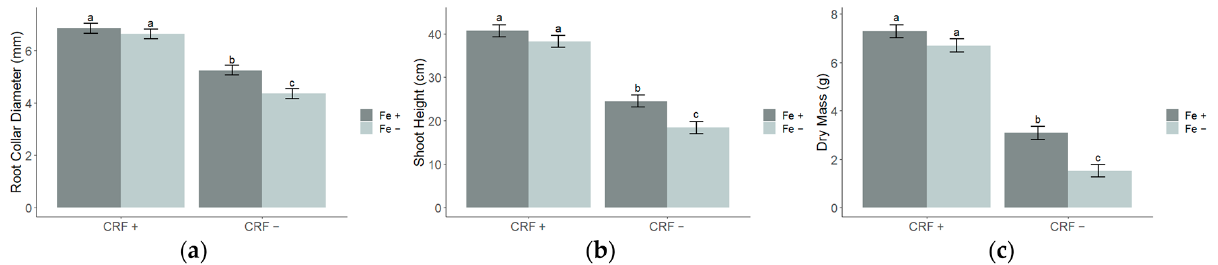
Figure 1. The mean ( ± SE) ( a ) dry mass, ( b ) root collar diameter, and ( c ) shoot height values of S. paniculatum seedlings at the end of the experiment. Different letters indicate significant differences among treatments ( α = 0.05). CRF improved growth in all treatments, although chelated iron only improved growth when applied without CRF.